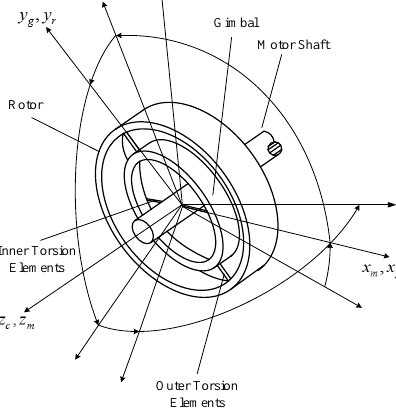
Figure 2. Reference frames and gimbal angles.